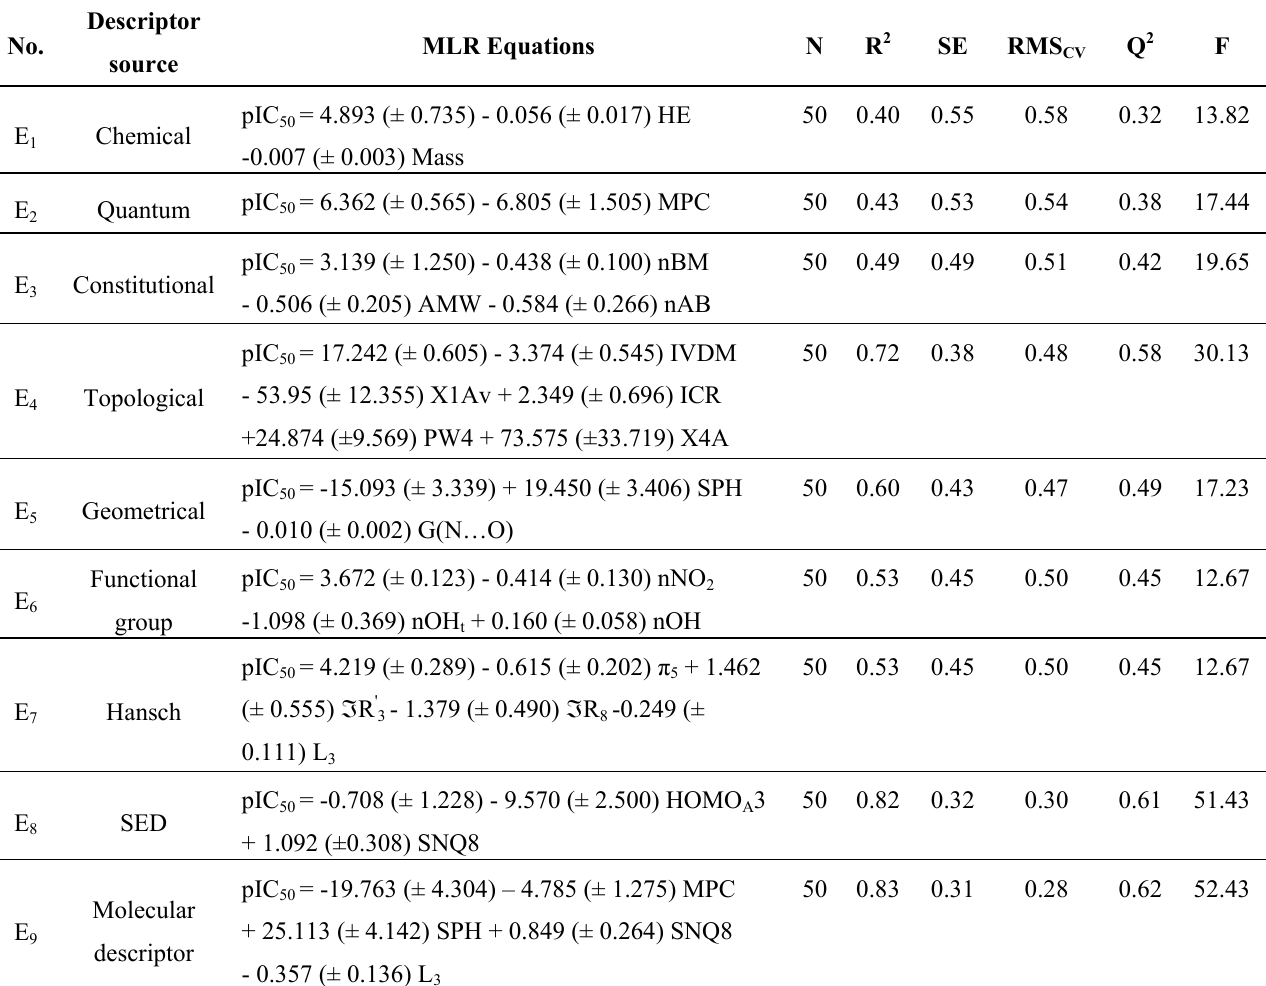
Table 3. The results of MLR analysis with different types of